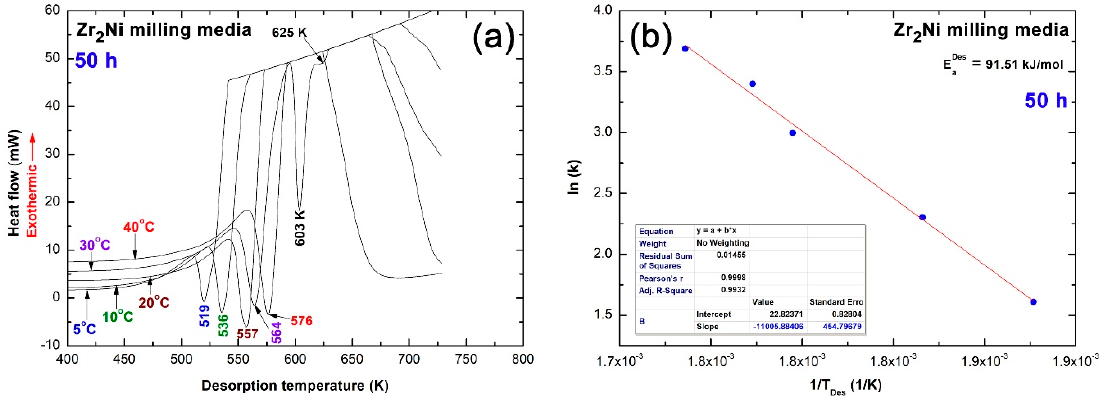
Figure 8. ( a ) Normal di ff erential scanning calorimetry (DSC) thermograms of MgH 2 powders milled with Zr 2 Ni balls for 50 h obtained at di ff erent heating rates (k), and ( b ) Arrhenius plot displaying the natural logarithmic values of k versus the inverse of the decomposition peak temperature (1 / T Des ) denoted in ( a ).